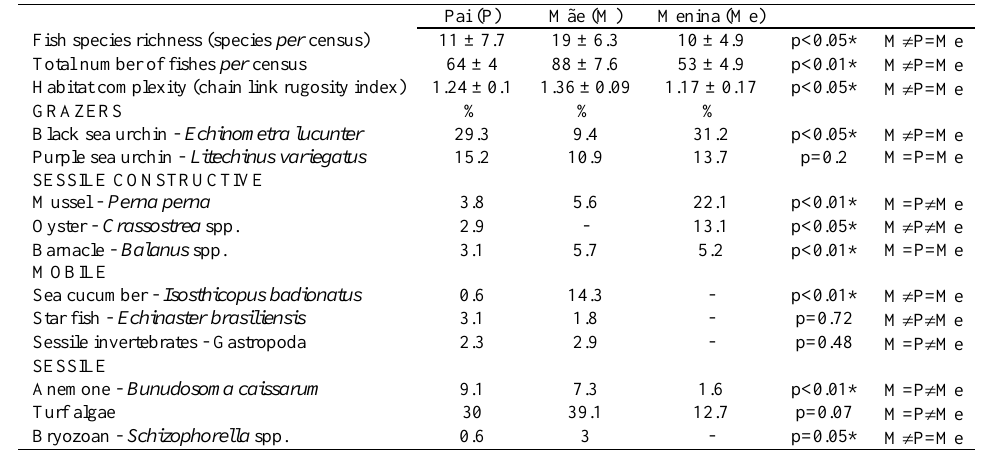
Table 2 . Summary of fish community (means ± standard deviation), habitat complexity and benthic composition (relative percent abundance) plus ANOVA results among sites. * Significant